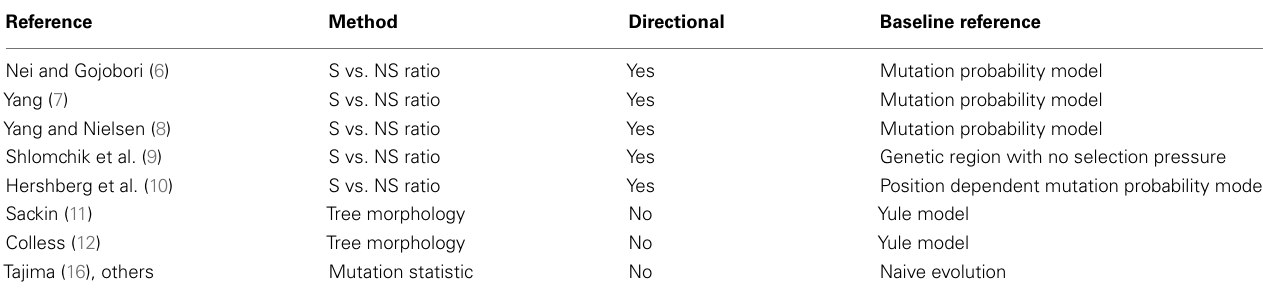
Table 1 | List of existing methods based on their reference (first column), the method they use (second column), whether they can detect the direction of selection (third column) and the baseline to which they compare in order to define if selection took place (last column).